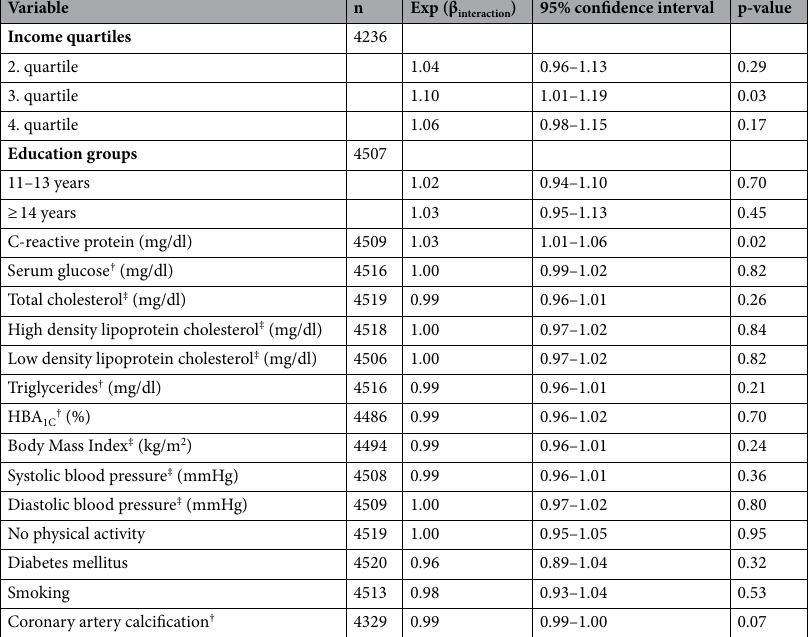
Table 4. Exp(β interaction ) and 95% confidence intervals (95% CI) of the interaction term for the interaction of socioeconomic and cardiovascular risk factors by the NT-proBNP-related genetic risk allele sum score on NT-proBNP in linear regression models separately for each socioeconomic and cardiovascular risk factor, adjusted for sex and age (lowest income/education group as reference). ‡ Exp(β) per standard deviation. † Exp(β) per interquartile